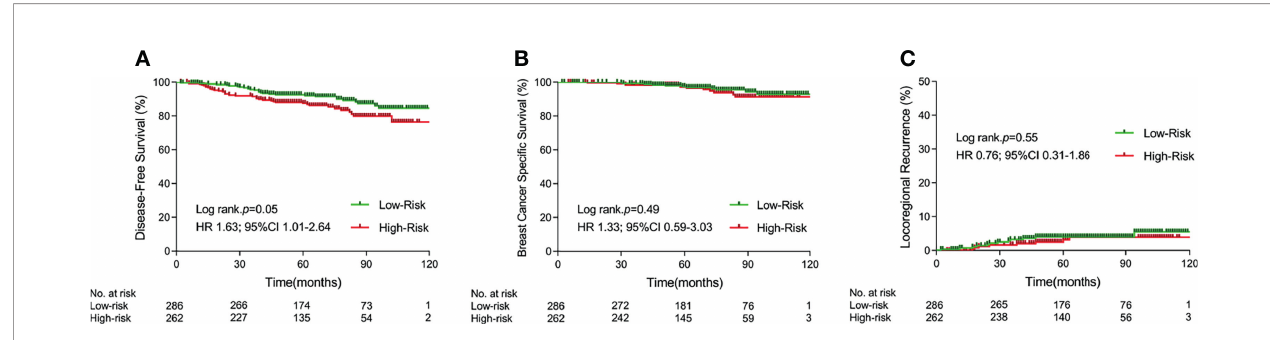
FIGURE 1 | Kaplan – Meier curves for 5-year disease-free survival (A) , 5-year breast cancer speci fi c survival (B) , and 5-year locoregional recurrence (C) in different risk cohorts. (PMRT,